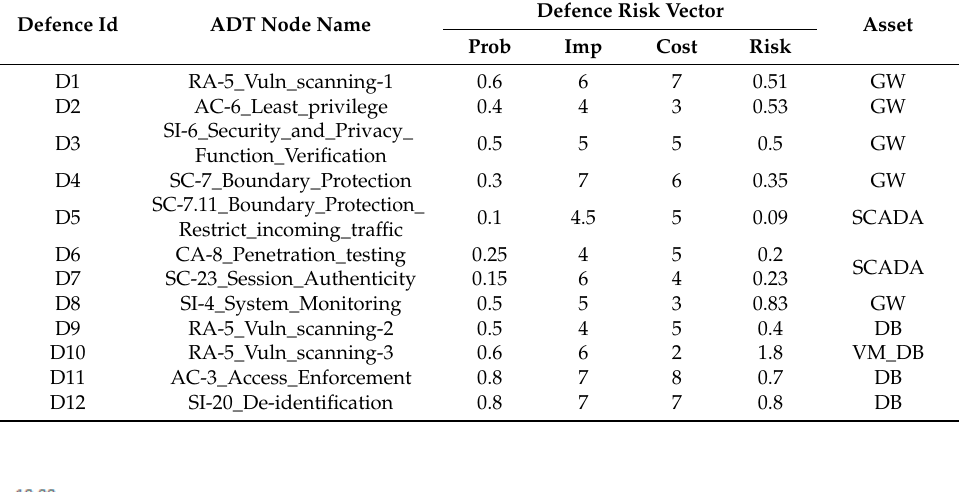
Table 5. Risk vectors for countermeasure nodes in the steal energy data ADT.